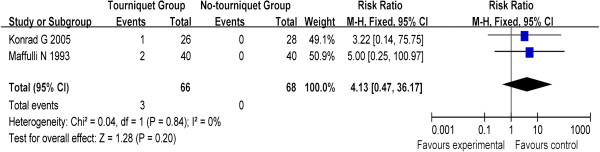
Meta-analysis of deep venous thrombosis incidence in the tourniquet and non-tourniquet groups.